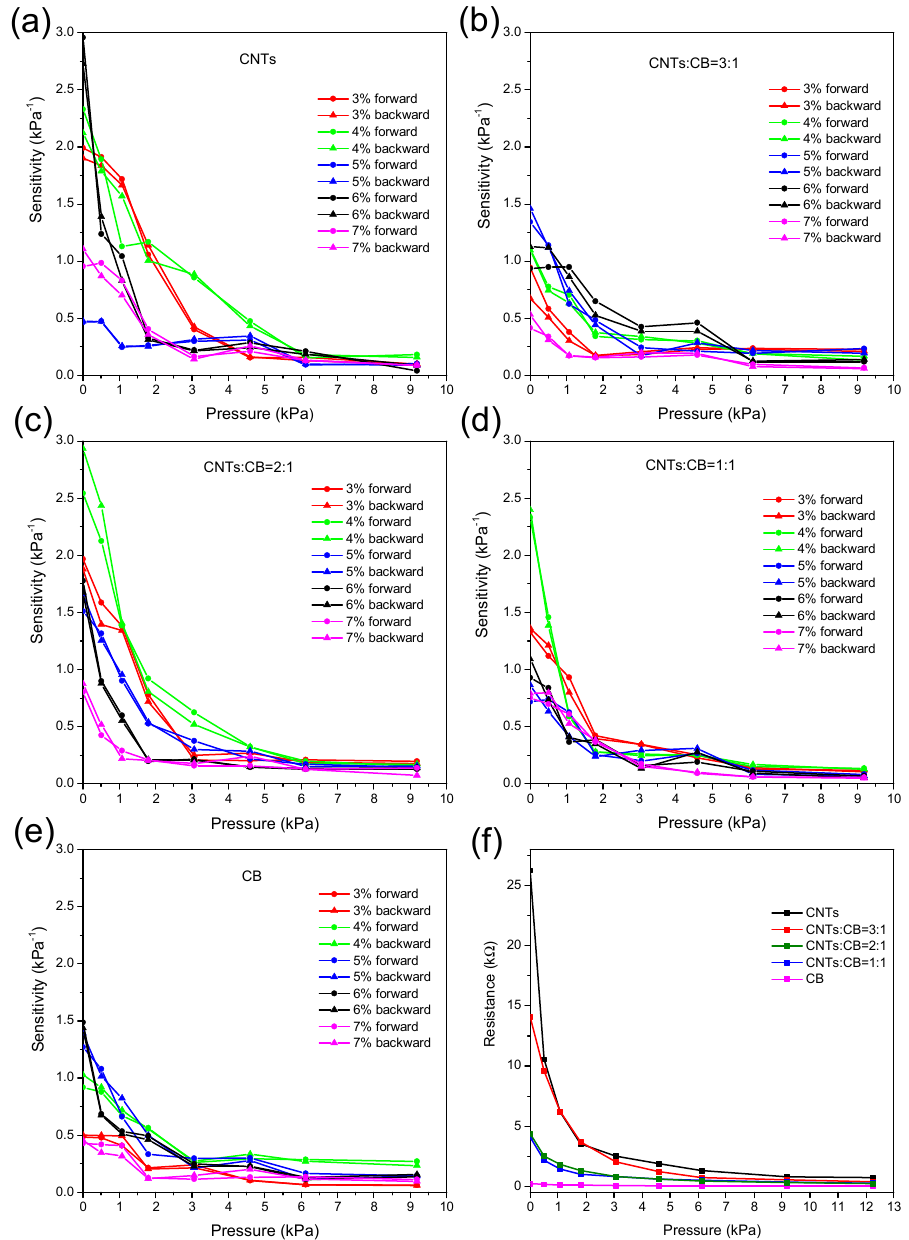
Figure 4. Sensitivity curves of the nanocomposite with different proportions of MWCNTs and CB. ( a ) MWCNTs only; ( b ) CNTs: CB = 3:1; ( c ) CNTs: CB = 2:1; ( d ) CNTs: CB = 1:1; ( e ) CB only; ( f ) resistance curve of the nanocomposite element at 6% CNT content.